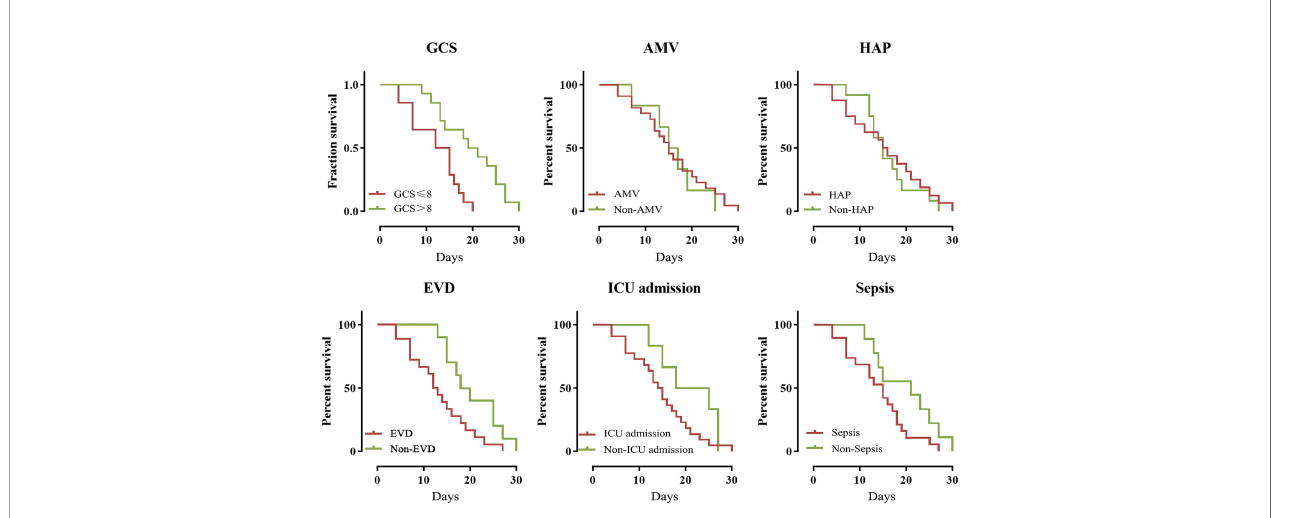
FIGURE 6 | Kaplan – Meier analysis of the 30-day mortality of patients who experienced nosocomial meningitis caused by multidrug-resistant Enterobacteriaceae (MDRE- NM). EVD , external ventricular drainage; GCS , Glasgow Coma Scale; ICU , intensive care unit; HAP , hospital-acquired pneumonia; AMV : assisted mechanical